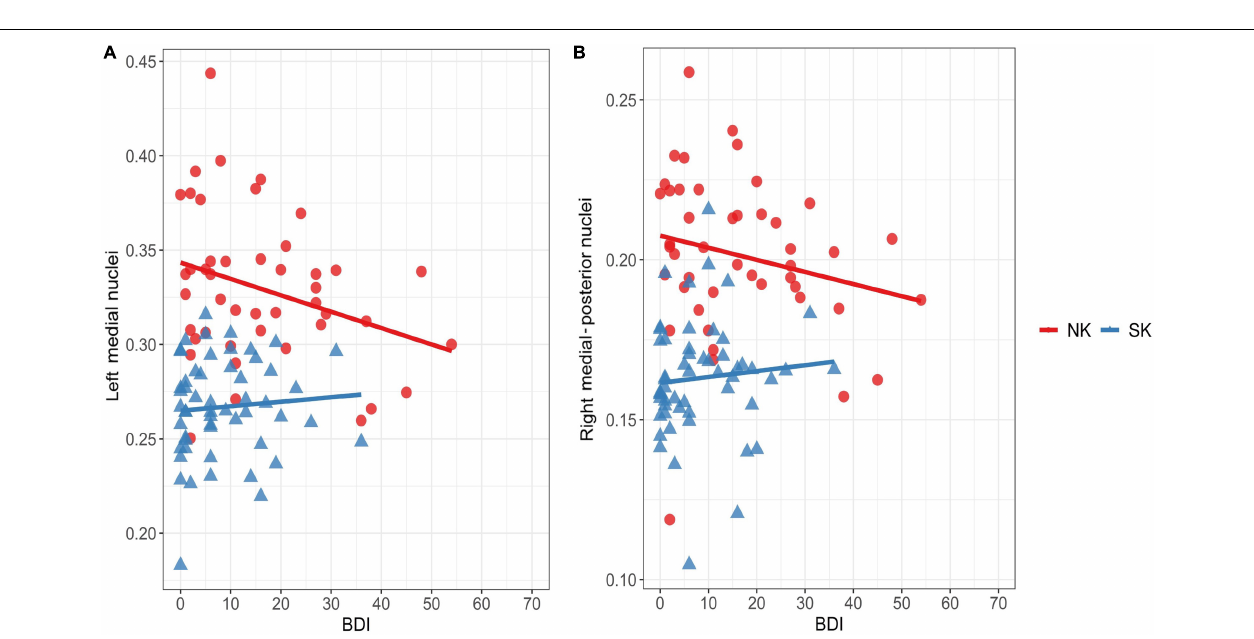
FIGURE 3 | Comparison of gray matter volume of thalamic nuclei group between NK refugees and SK residents in additional analysis using Freesurfer. NK refugees showed greater GM volumes in the left medial group and right medial, posterior than SK residents. ∗ p < 0.05, ∗∗ p < 0.01, ∗∗∗ p < 0.001.